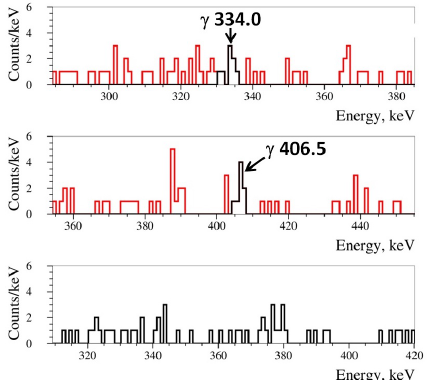
Figure 11. Coincidence spectra obtained in the experiment performed at STELLA facility of LNGS by using the four HP-Ge (GeMulti) detectors. In the top (middle) plot the spectrum of events with energy around 334 keV (406.5 keV) measured in coincidence with a 406.5 keV (334.0 keV) gamma in one HP-Ge detector is reported; the plot in the bottom represents a random coincidence background spectrum, see text and Reference [43].